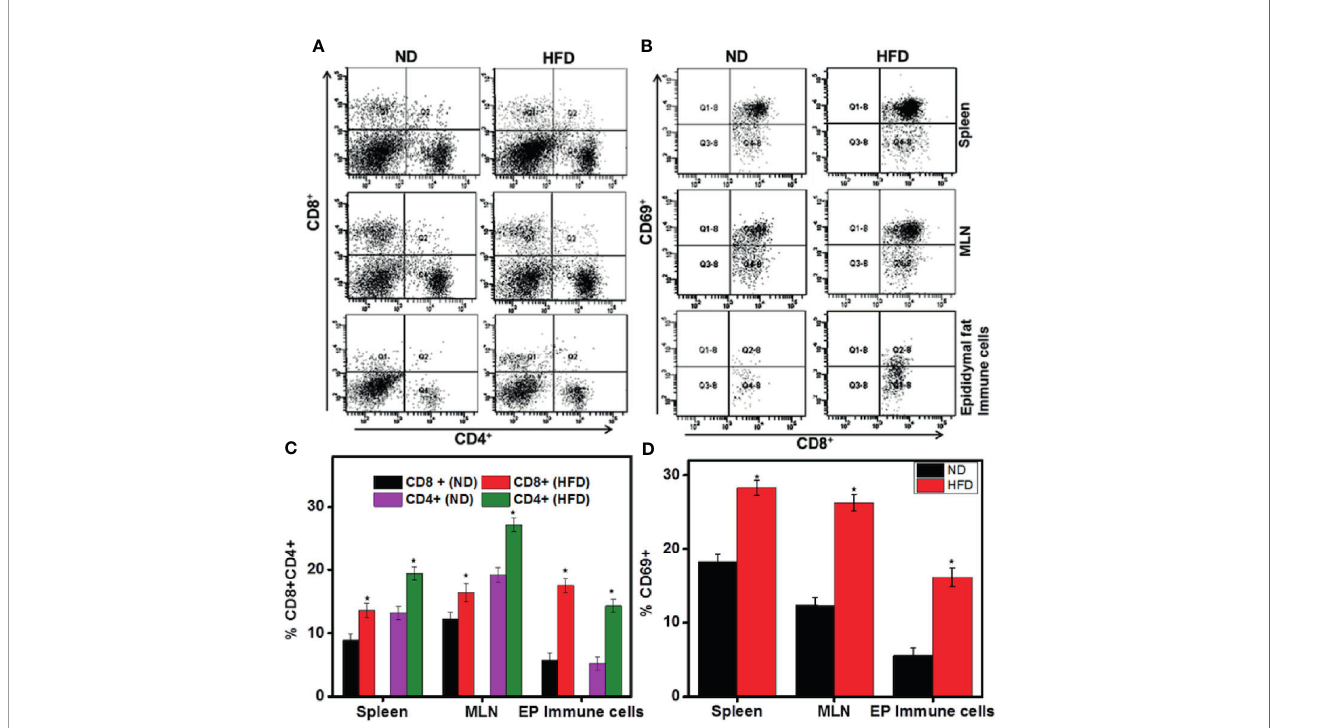
FIGURE 3 | DIO induces activated CD8 + T cells in the adipose tissue. Changes in CD4 + , CD8 + , and CD69 + T cells in mice 16 weeks after beginning the HFD. Splenic, mesenteric lymph nodes (MLNs), and epididymal adipose cells were isolated from the two groups of mice. Changes in the frequency and percentage of CD4 + and CD8 + T cells (A, C) , and CD8 + CD69 + T cells (B, D) were determined by fl ow cytometry and expressed as the mean percentage of cells/mouse ± SEM. The statistical signi fi cance between ND and HFD is assessed by Student ’ s t-test. *p < 0.05 indicate statistically signi fi cant differences in CD4 + , CD8 +, and CD69 + T cells between ND and those fed HFD. The cumulative data shown are from a representative experiment, total n=18; three independent experiments involving six mice per group yielded similar